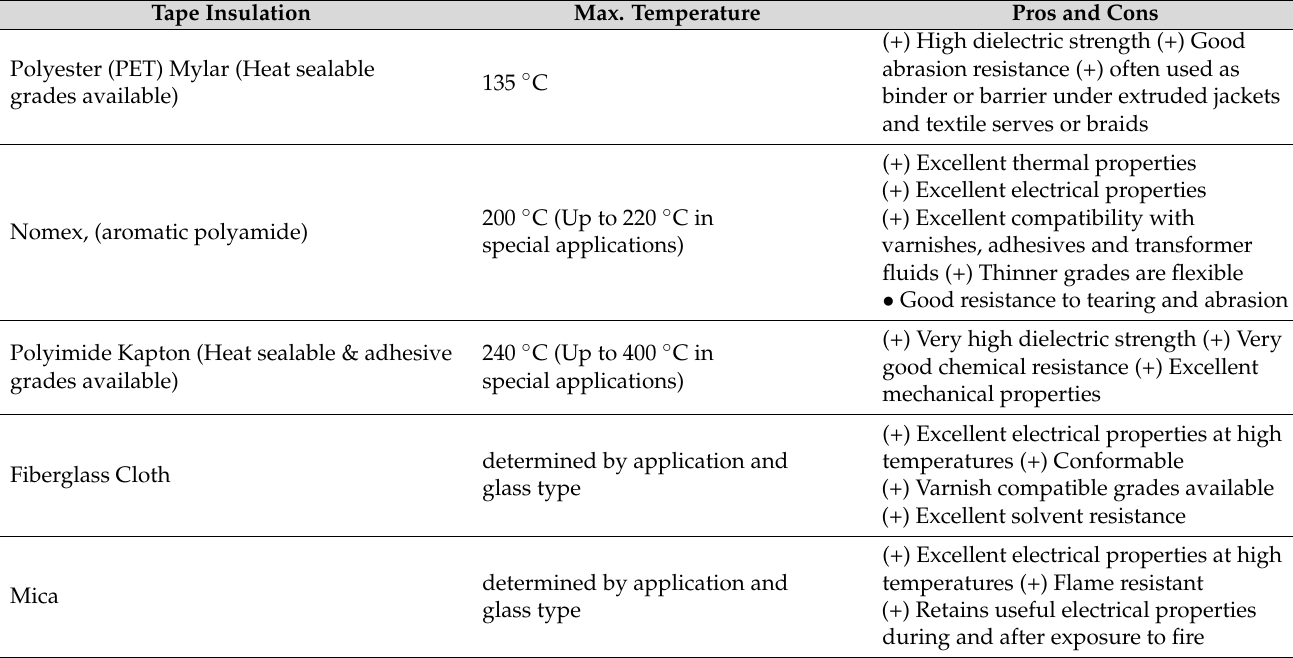
Table A2. Classification of tap and fiber insulation based on their thermal class